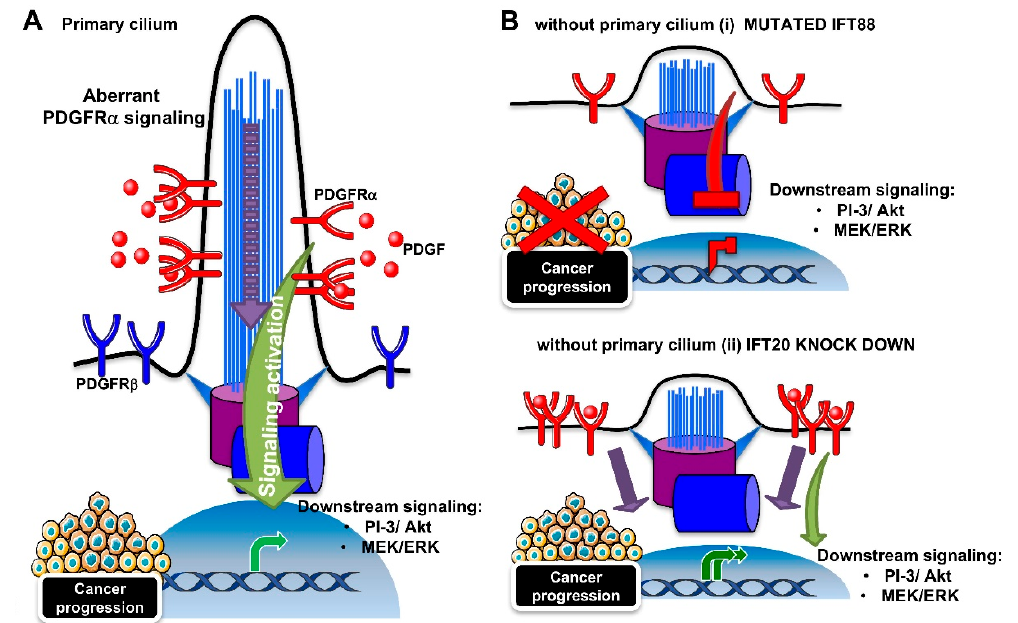
Figure 3. Cilia-dependent regulation of PDGFR α signaling pathway. ( A ) Schematic representation of the cilia-dependent PDGFR α signaling pathway. The α isoform of the PDGFR receptor is located at the ciliary membrane, whereas the β isoform is on the plasma membrane. The binding of the PDGF ligand to the PDGFR α receptor activates downstream signaling, such as PI-3/Akt and MEK/ERK. The aberrant activation of the pathway induces tumorigenesis. ( B ) The absence of the cilium can (i) repress the aberrant PDGFR α signaling pathway, thus potentially inhibiting tumorigenesis, or (ii) hyperactivate the pathway, due to a PDGFR α mislocalization to the plasma membrane, thus expanding the signal and inducing tumorigenesis. ERK: Extracellular signal–regulated kinase; IFT: Intraflagellar transport; PDGF: Platelet-derived growth factor; PI-3: phosphoinositide-3; PDGFR α Platelet-derived growth factor receptor α